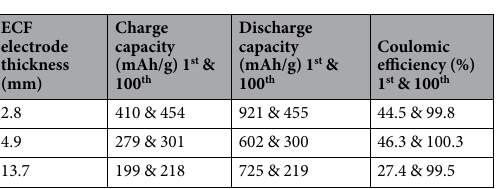
Figure 5. Galvanostatic charge-discharge tests of the ECF with different thicknesses at a current density of 0.04 A/g at 1 st ( A ) and 100 th cycle ( B ).